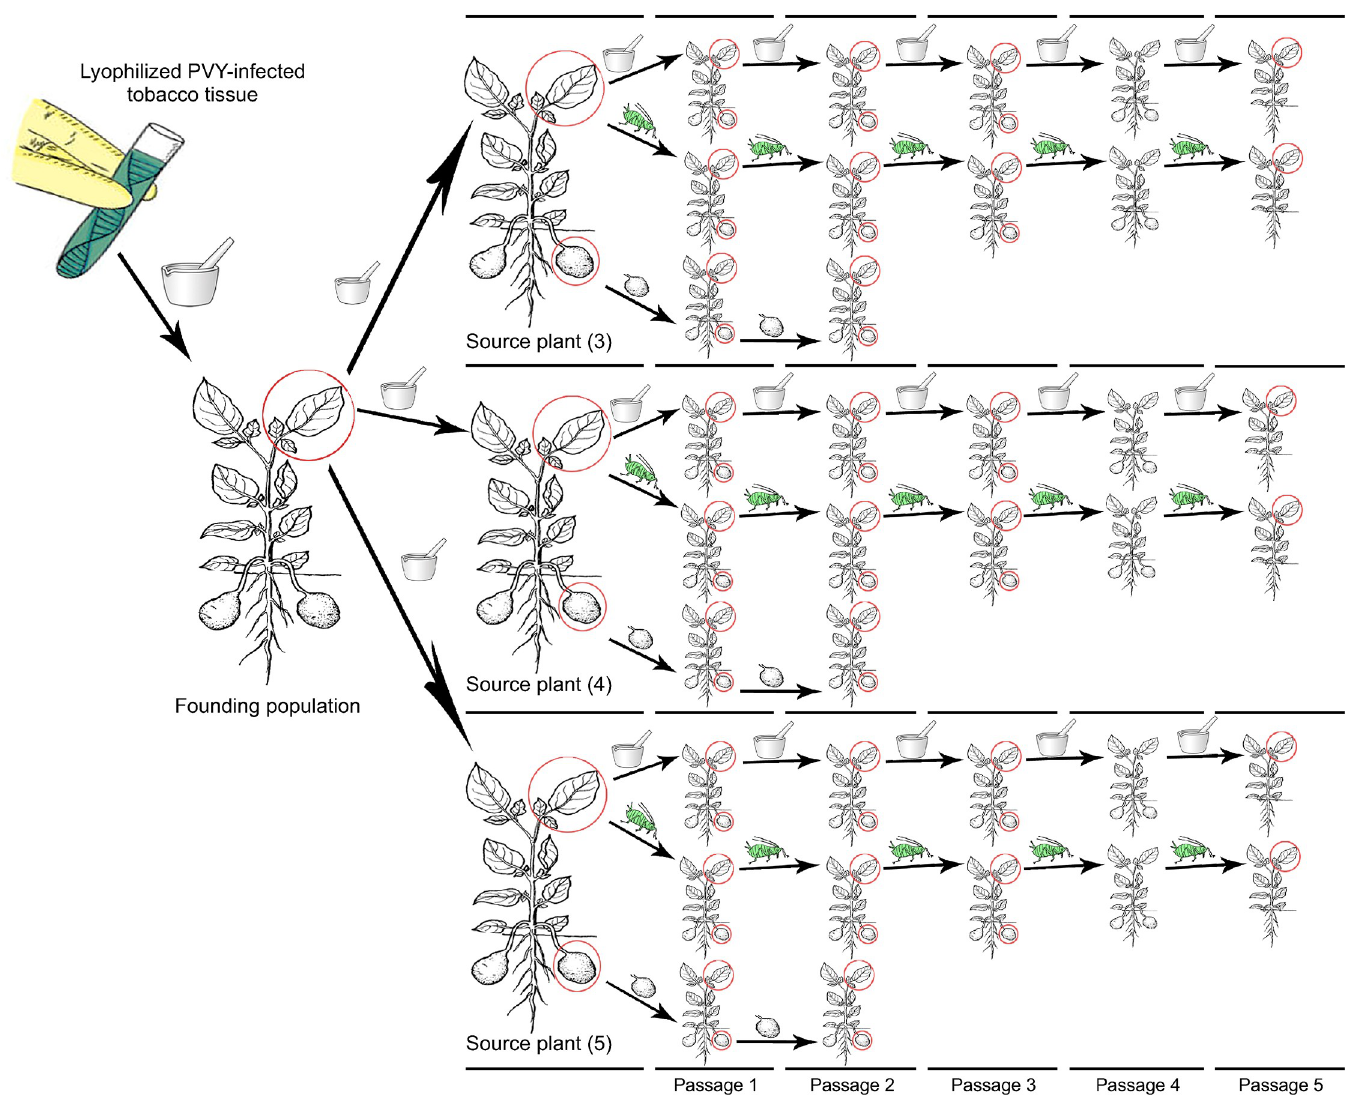
Fig 1. Experimental Design. PVY infected lyophilized tobacco tissue was used to mechanically inoculate a single founding potato plant. Virus from the founding plant was used to mechanically inoculate three potato plants (source plants, designated number 3, 4 and 5). Each source plant was considered a replication and used as virus source for each transmission mode: AT—aphid transmission (represented by the aphid cartoon), MI—mechanical inoculation (represented by mortar and pestle cartoon), and IT—infected tuber (represented by the potato tuber cartoon). Each time the virus was transmitted to a new plant it was counted as a passage. A leaf and a tuber (represented by the red circle) were sampled, at harvest, from designated plants to compare the virus populations in those locations and among each transmission mode over time. The same procedure was conducted for each of the three PVY strains, PVY O , PVY N , and PVY N-Wi .